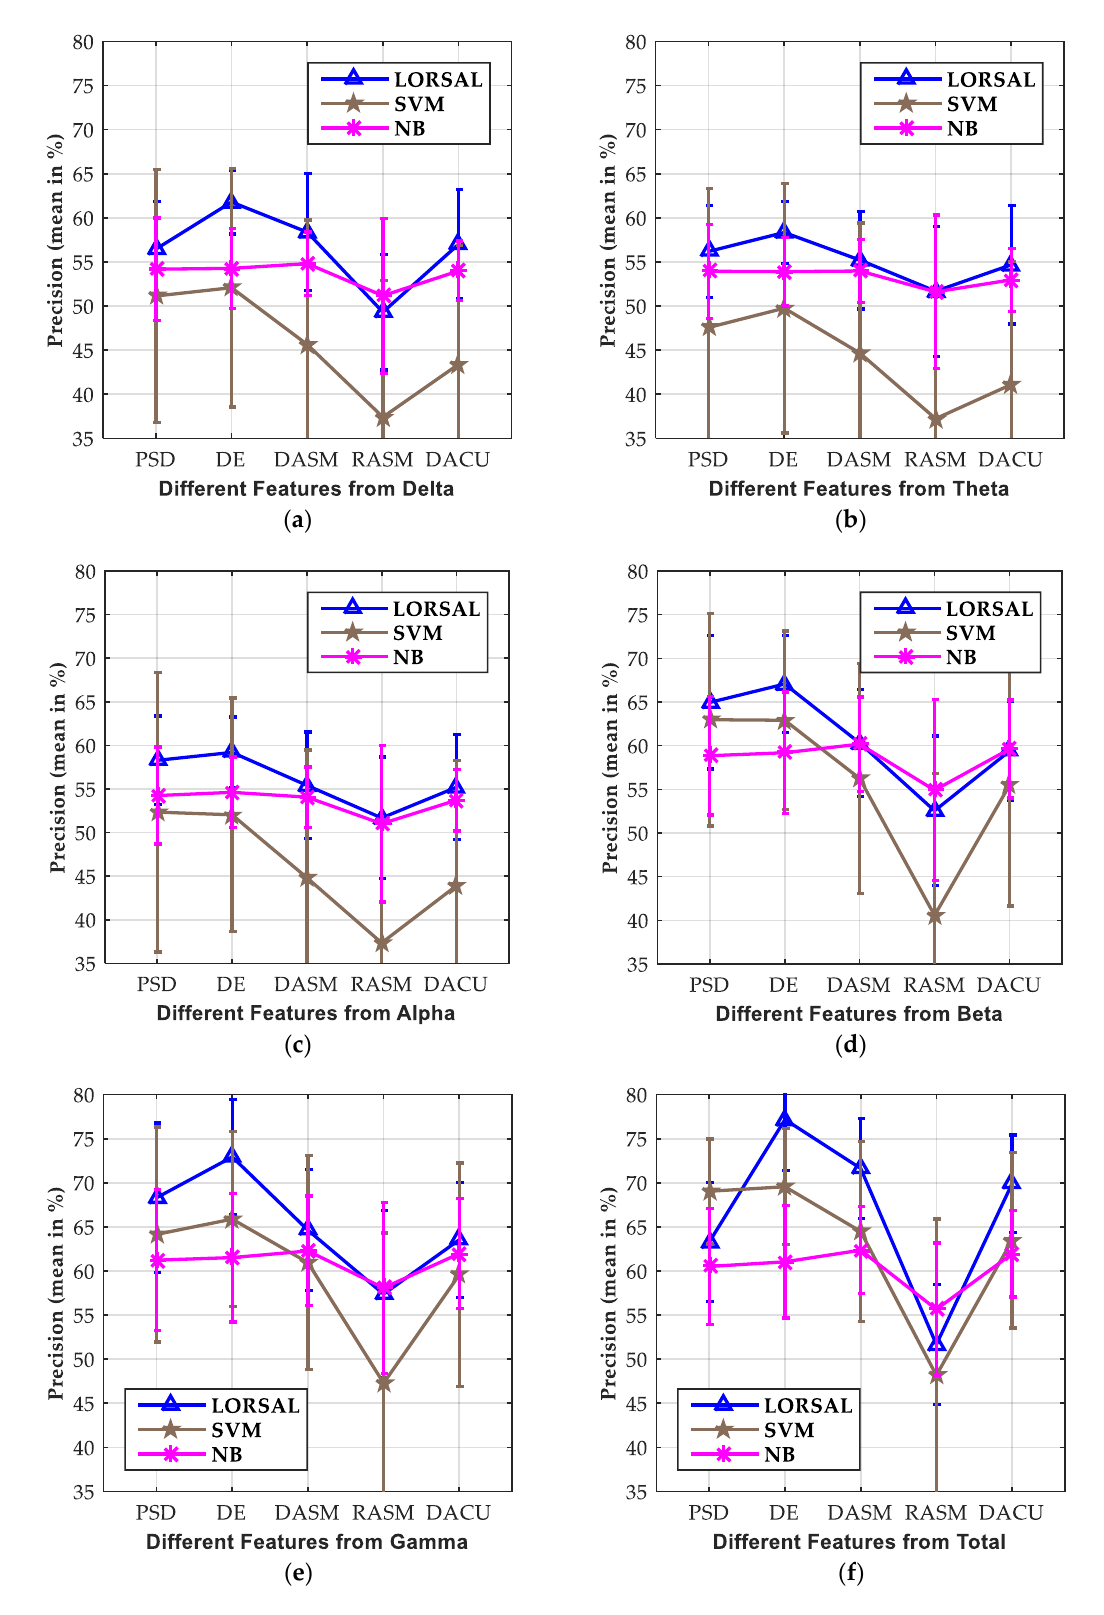
Figure 7. Effects of the different features (PSD, DE, DASM, RASM, and DCAU) on the classification precisions for LV/HV emotions obtained by the LORSAL, SVM, and NB classifiers from the six different frequency bands: ( a ) Delta, ( b ) Theta, ( c ) Alpha, ( d ) Beta, ( e ) Gamma, ( f ) Total.